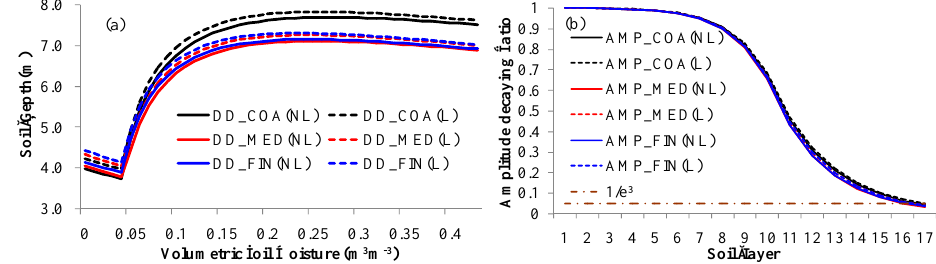
Figure 3. The variation of required soil depth for simulating annual cycles of soil temperature/heat flux with volumetric soil moisture (a) , and the variation of soil temperature/heat flux amplitude decaying ratio with soil layers (b) for different soil textures: coarse (COA), medium (MED), and fine (FIN). The soil heat convection by liquid water transport (8.64mmd − 1 ) is considered in “L” (dashed line), and it is excluded in “NL” (solid line). The black, red, and blue lines represent coarse, medium, and fine soils,